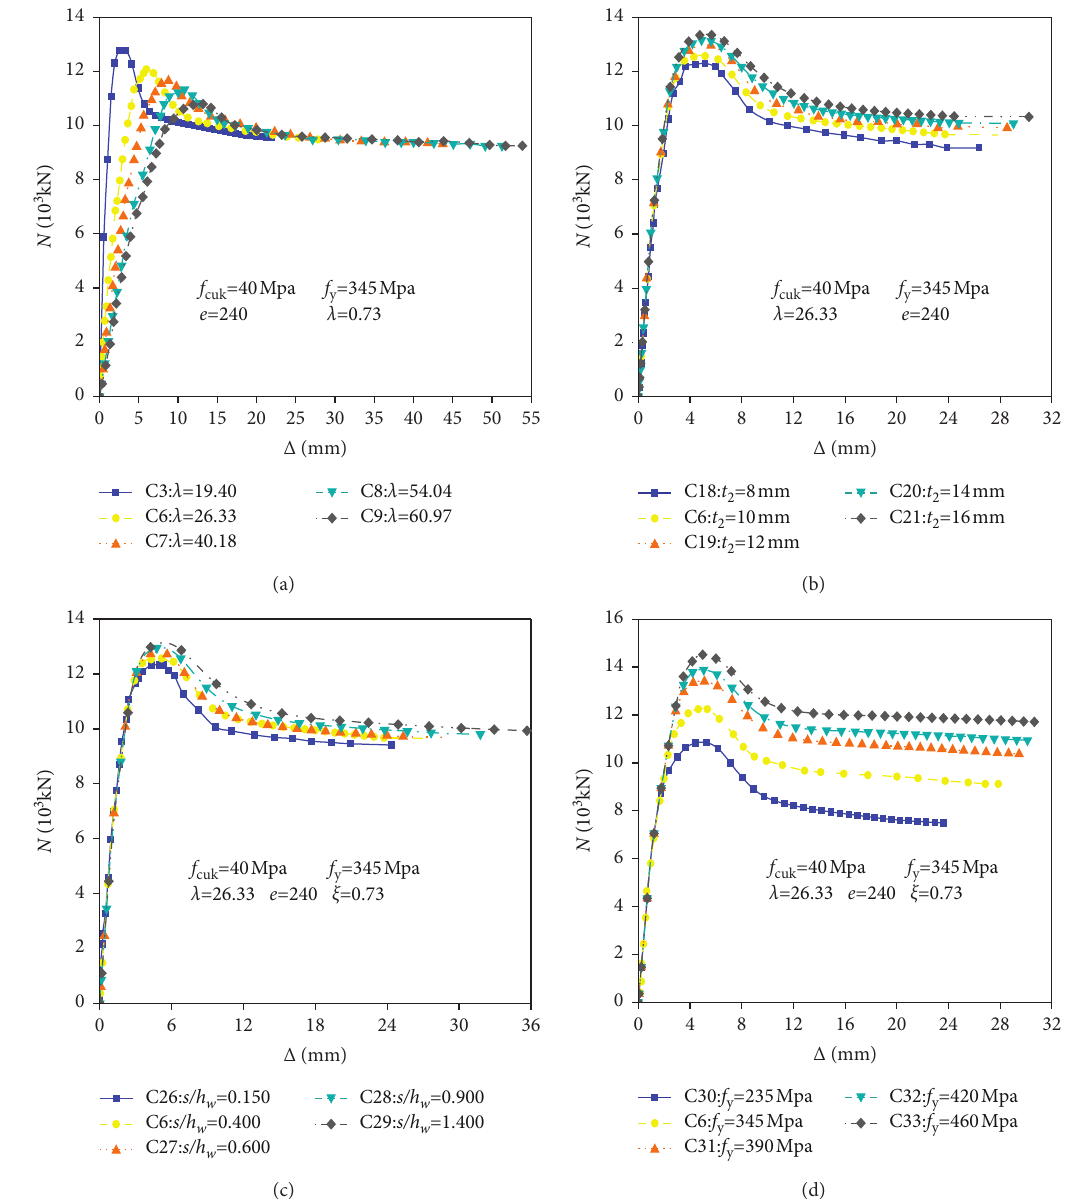
Figure 9: Comparisons of N - Δ curves of STHCCs with different parameters. (a) λ . (b) t